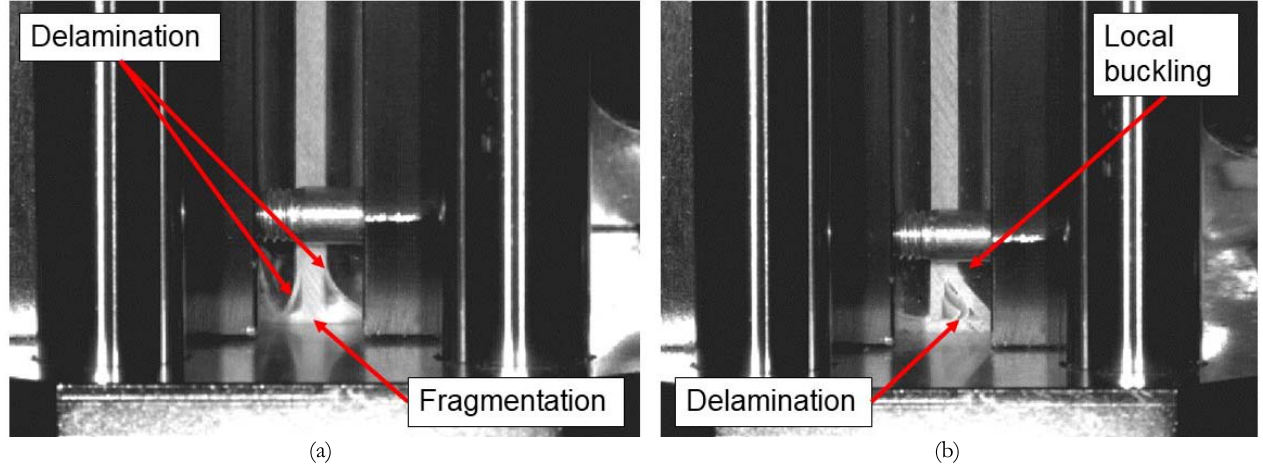
Figure 7: Identification of the failure modes in different moments of the same test on glass fiber specimens, as recorded through the high- speed camera at the beginning of the test (a) and at the end of the test (b). The failure mode is a combination of splaying, fragmentation and local